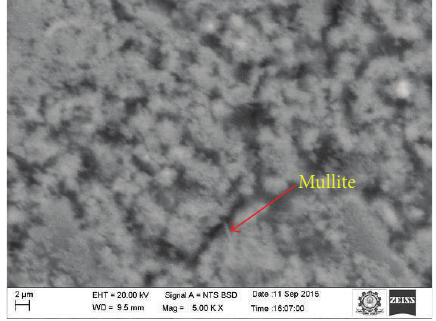
Figure 5: SEM image for SFCS15